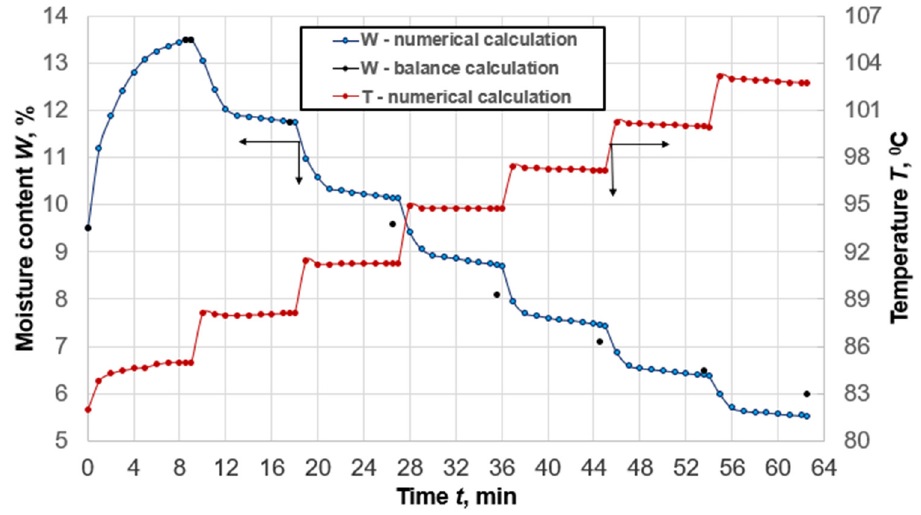
Figure 3. Change in average values of humidity and temperature of compressed castor seed in time in the process of wet–heat treatment in a seven-vat brazier, obtained by mathematical model (lines) and balance calculations (dots).